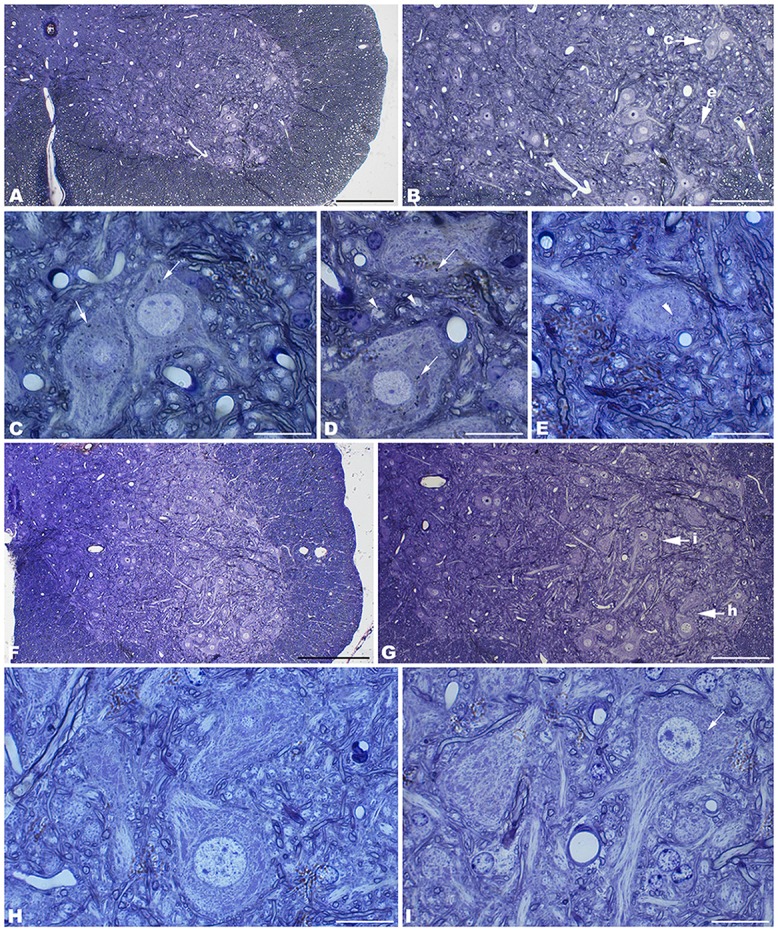
Coronal sections through the spinal cord of 4- (A–E) and 1- (F–I) month-old tbl/tbl mice. In the older mutant mice, abundant dark accumulations are observable within the cytoplasm of the cell soma (arrows in C,D) and the dendrites (arrowheads in D,E) of the motor neurons. In contrast, few of these dark aggregates can be found in the younger animals (arrow in I). Bars = 200 μm (A,F), 100 μm (B,G), and 20 μm (C–E,H,I).